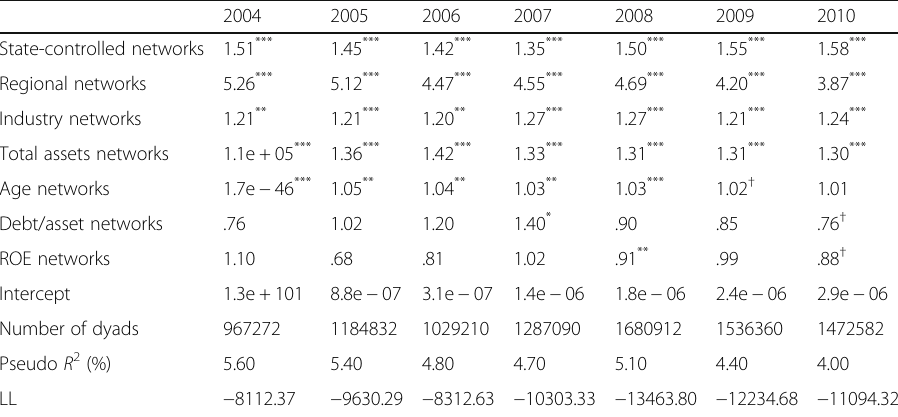
Table 4 State as the ultimate controller and interlocking directorate networks: 2004 – 2010, QAP logistic regression